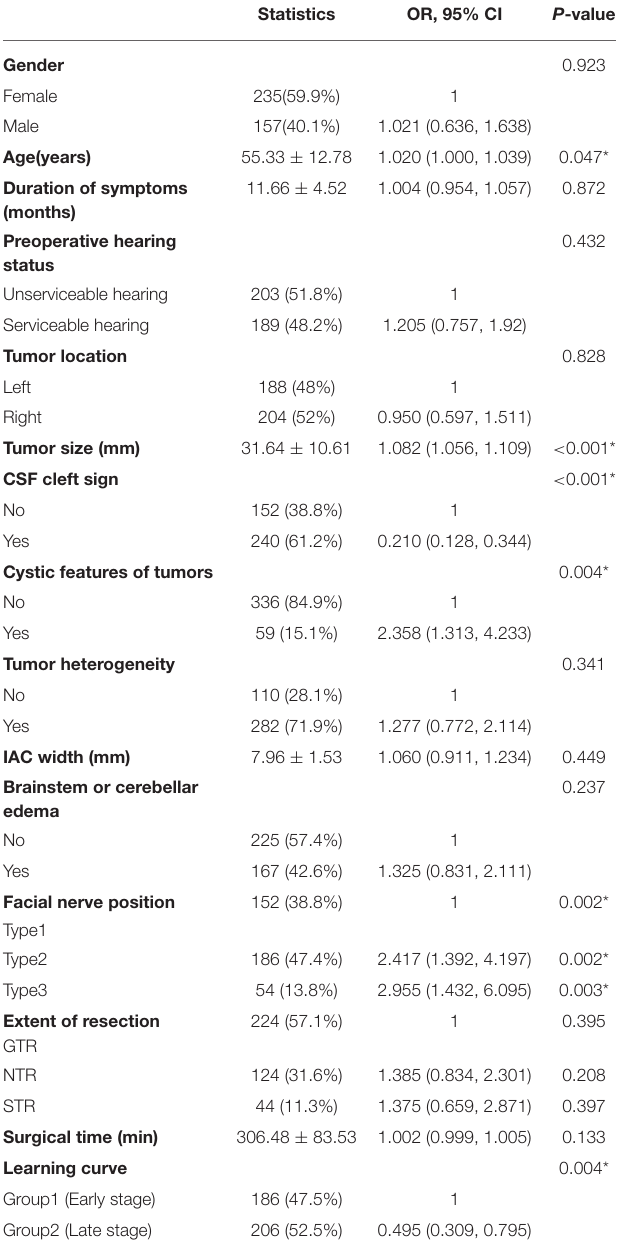
TABLE 2 | The univariate logistic regression analysis of facial nerve outcomes after surgical resection of vestibular schwannoma.